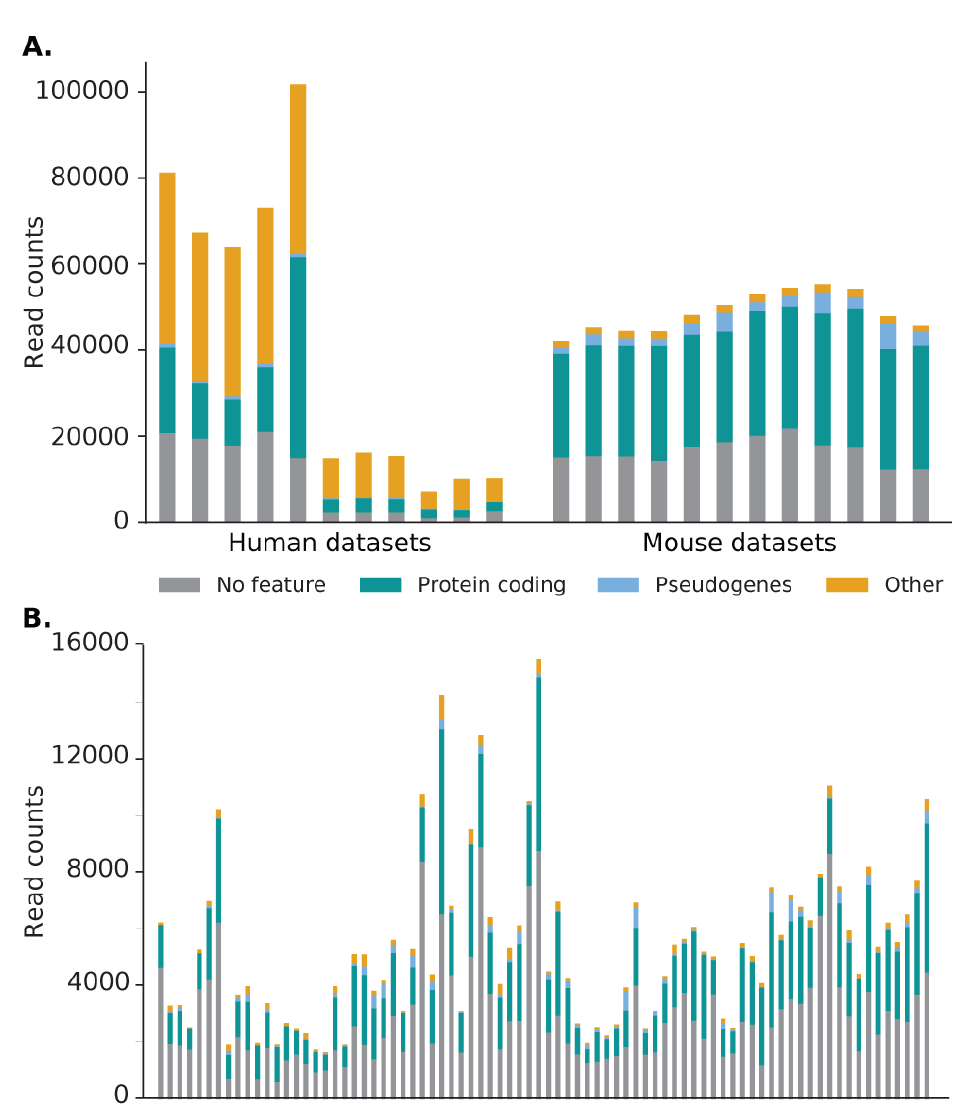
Figure 6. Distribution of Scavenger recovered reads categorised by gene type for normal (A) and single-cell (B) RNA-seq datasets. In general, most reads are located in a region without a feature or within a protein coding gene. However, a high percentage of reads in human bulk RNA-seq datasets are located in other gene types, more specifically mitochondrial genes, due to the high source expression of these genes.